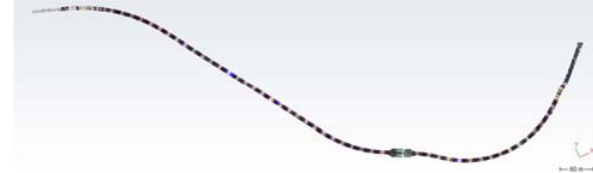
Fig. 2: Whole tunnel point cloud